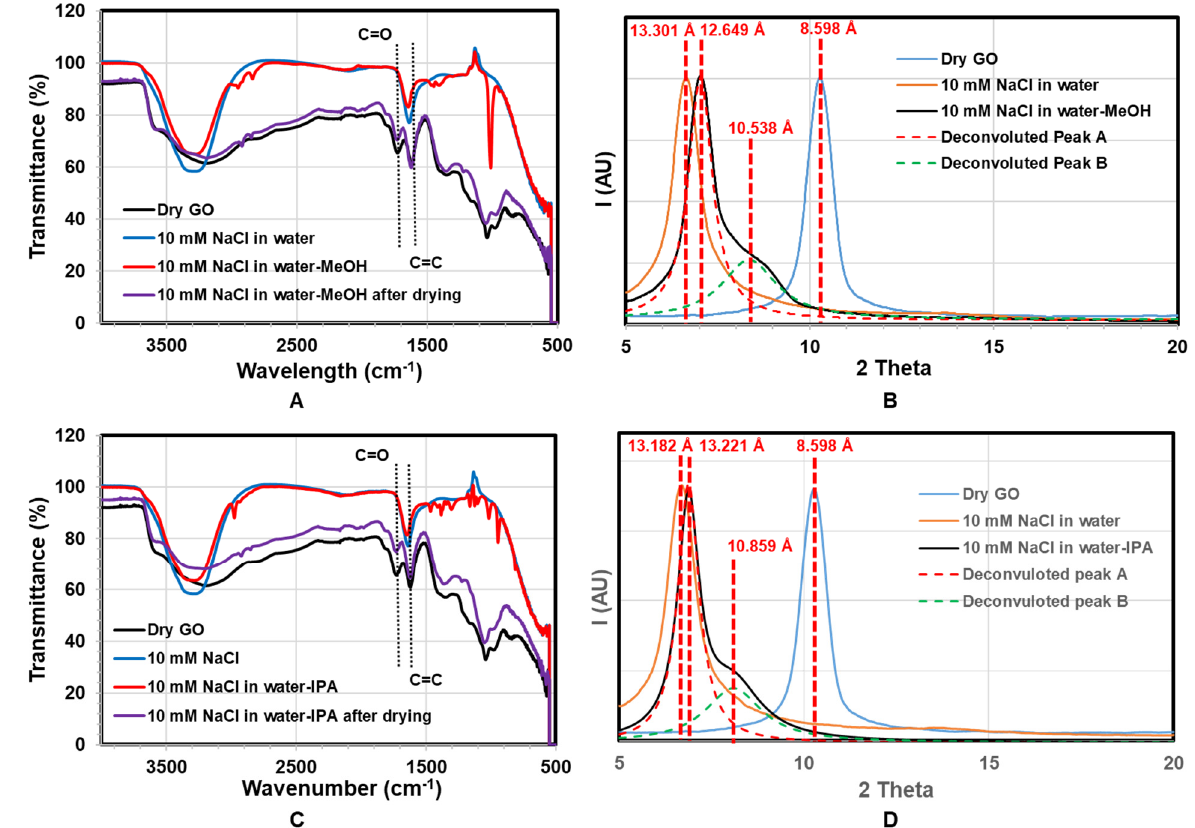
Figure 6. ATR-IR and corresponding XRD data on the same membrane. ( A ) ATR-IR of GO membrane immersed in water and water-MeOH; ( B ) corresponding XRD data of GO membrane immersed in water and water-MeOH; ( C ) ATR-IR of GO membrane immersed in water and water-IPA; ( D ) corresponding XRD data of GO membrane immersed in water and